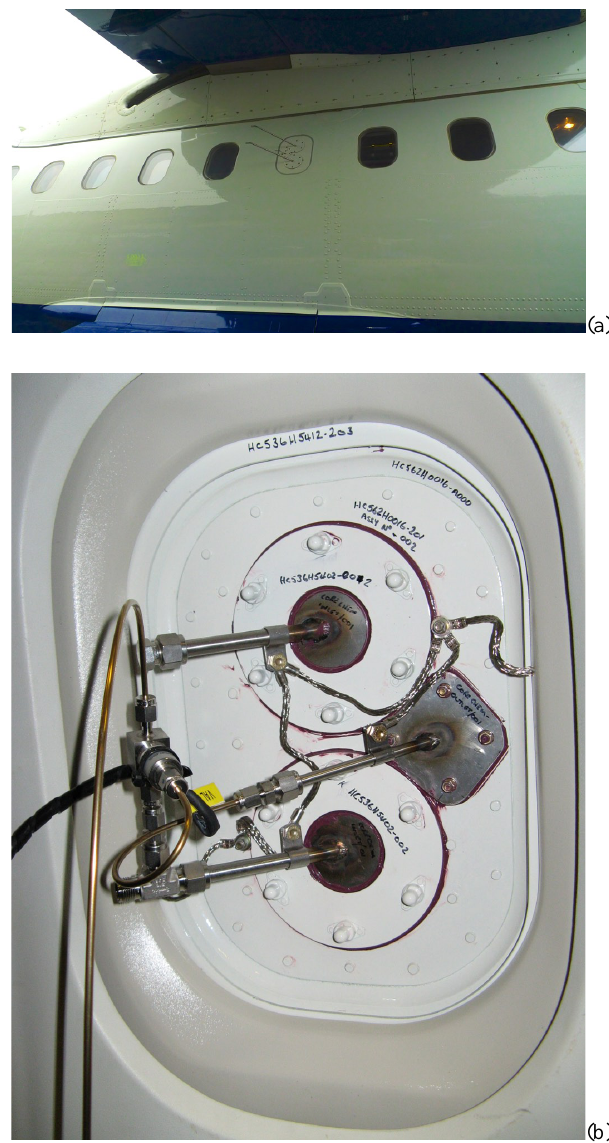
Fig. 2. (a) Outboard view of the FAAM core chemistry instrumen- tation inlet window fitted on starboard side window #14, under the FAAM BAe-146 wing. The lower 3/8 00 OD rearward facing SS tube is the FGGA’s dedicated inlet. The short 1/4 00 OD rearward facing SS tube is the calibrant outboard vent. (b) Inboard view of FAAM core chemistry instrumentation inlet window. The 3-way calibra- tion valve V1 is showed on the lower 3/8 00 OD SS tube. The central 1/4 00 OD tube is the calibrant outboard vent (connected to valve V1 normally open